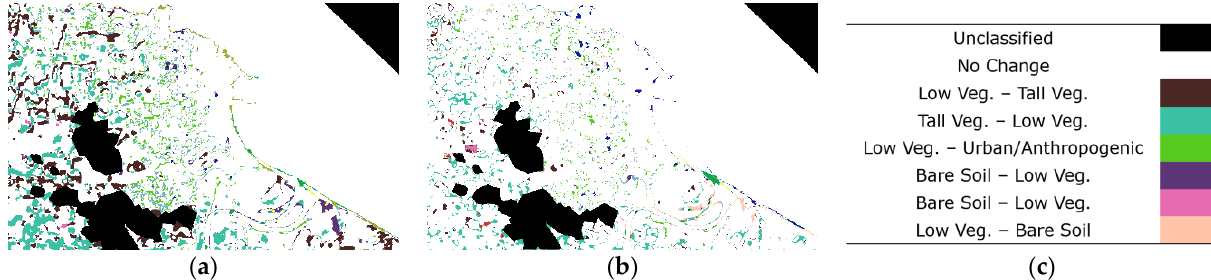
Figure 9. Change maps obtained on the “Jérémie 2017”, “Jérémie 2018”, and “Jérémie 2019” datasets: ( a ) change map specifying the changes that happened between 2017 and 2018; ( b ) change map specifying the changes that happened between 2018 and 2019; ( c ) legend representing the class transitions in the change maps. Table 2. Accuracy scores on the test samples for the classification maps corresponding to the da- tasets “Jérémie 2018” and “Jérémie 2019” and obtained with the 2017–2018 and 2018–2019 temporal pairs, respectively. The corresponding maps are shown in Figure 8a,b.